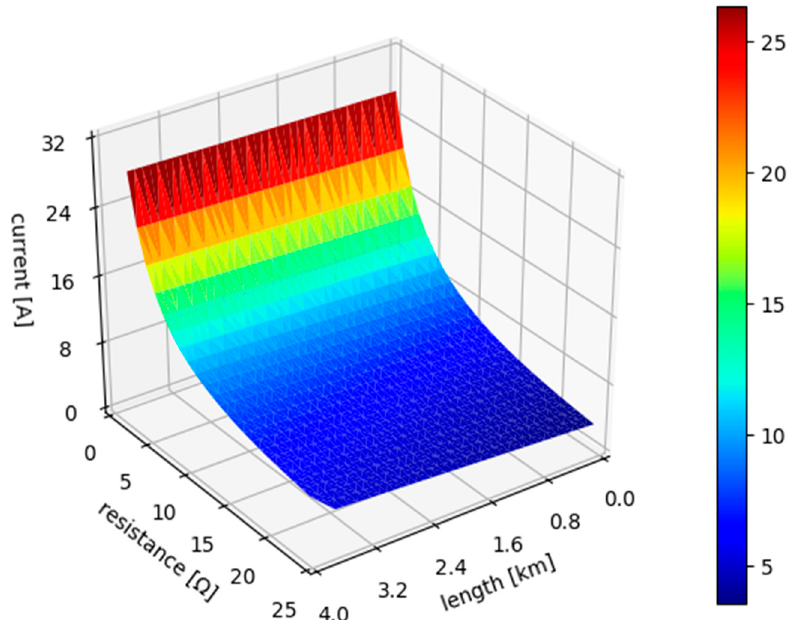
Figure 10. Current in the middle cable with additional resistance; formation presented in Figure 2c.